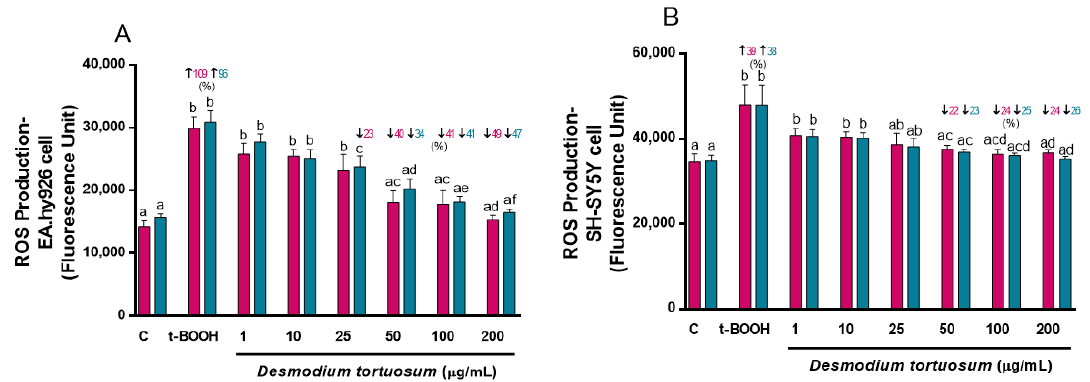
Figure 3. D. tortuosum extract effect on NO levels induced by t-BOOH in EA.hy926 ( A ) and SH-SY5Y Figure 1. Cytoprotective effects by D. tortuosum extract on EA.hy926 ( A ) and SH-SY5Y ( B ) cells after ( B ) cells after co-treatment (red bars, █ ) and pre-treatment (blue bars, █ ) periods. NO levels are co-treatment (red bars, █ ) and pre-treatment (blue bars, █ ) periods. Data are presented as % control, EA.hy926 ( A ) and SH-SY5Y ( B ) cells after co-treatment (red bars, ) Figure 2. Antioxidant effects by D. tortuosum extract on ROS production induced by t-BOOH in and as mean ± SEM of six independent experiments. a,b,c,d Different letters show significance between presented as % of control-change. Data represent the mean ± SEM of six independent experiments. periods. ROS production was measured as fluorescence units. Data are presented as mean ± SEM EA.hy926 ( A ) and SH-SY5Y ( B ) cells after co-treatment (red bars, █ ) and pre-treatment (blue bars, groups at p < 0.05. ↓ represents percentage decrease with respect to control, ↑ represents percentage of six independent experiments. a,b,c,d,e,f Different letters show significance between groups at █ ) periods. ROS production was measured as fluorescence units. Data are presented as mean ± SEM increase with respect to t-BOOH. p < 0.05. ↑ represents percentage increase with respect to control, ↓ represents percentage decrease of six independent experiments. a,b,c,d,e,f Different letters show significance between groups at p < 0.05. ↑ represents percentage increase with respect to control, ↓ represents percentage decrease with with respect to respect to t-BOOH.